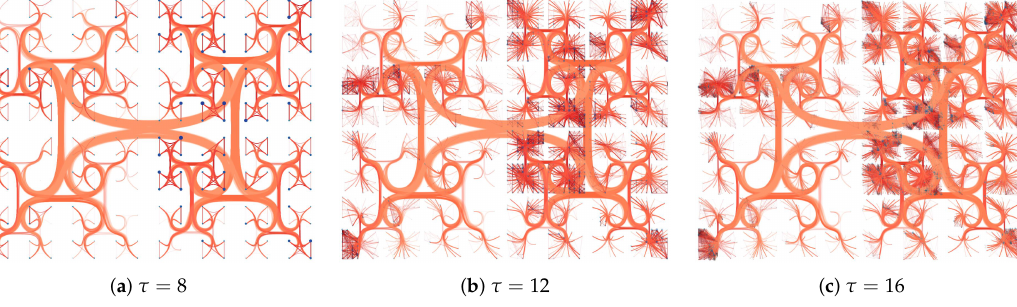
Figure 16. Multi-scale bundling of the amazon dataset. As more information is added to the graph representation (larger τ ), it becomes evident that only few vertices represent clusters of